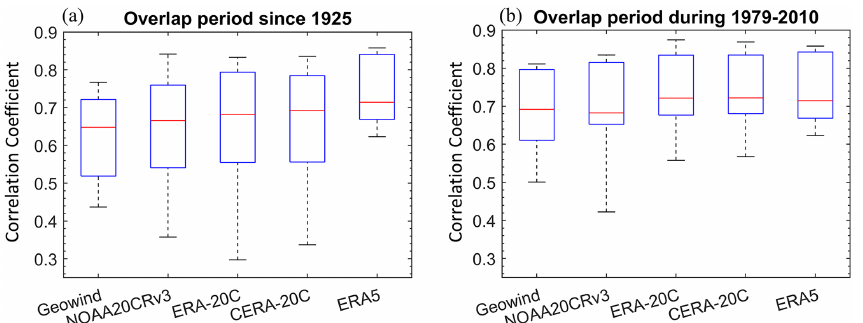
Figure 2. Box plot for correlation coefficients of monthly wind speed anomaly series between the rescued data at the 13 stations and the geowind or reanalysis data at the collocated grids (a) during the paired overlap periods since 1925 and (b) during the all-datasets overlap period,